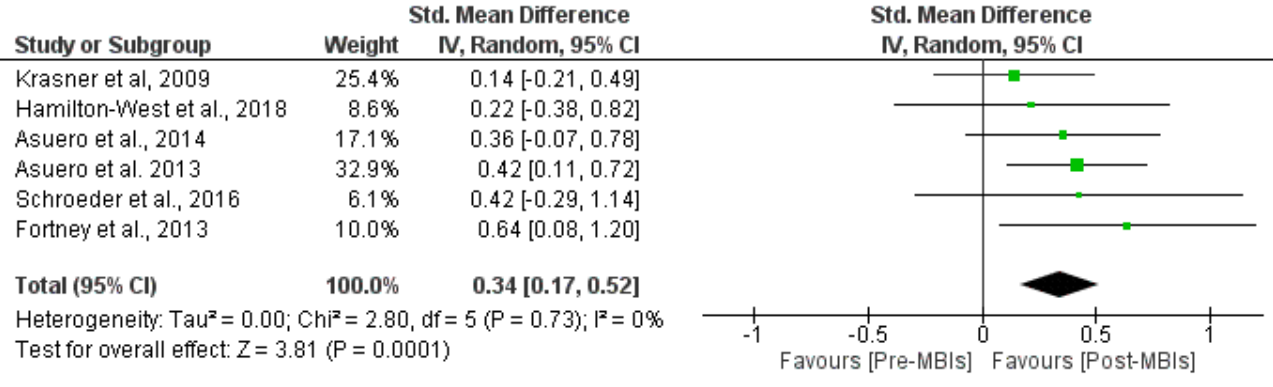
Figure 4. Effect of mindfulness-based interventions (MBIs) on personal accomplishment in primary healthcare professionals. Results are reported as standardized mean difference and 95% confidence interval (CI).